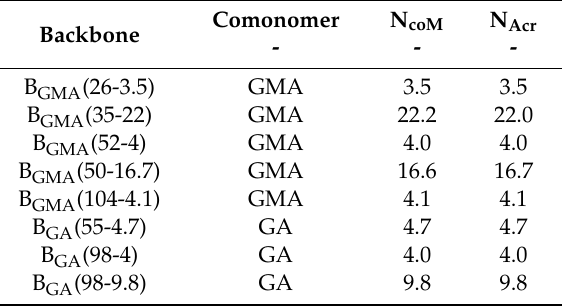
Table 2. Number of co-monomers (GA or GMA, N coM ) and number of acryloyl groups per chain in the backbones.